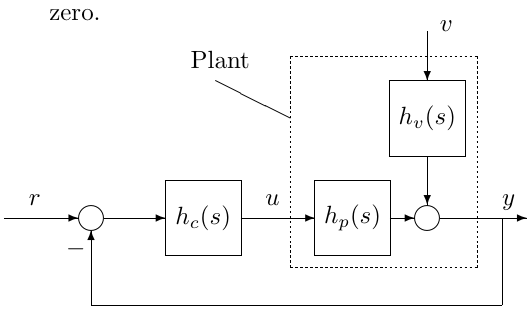
Figure 1: Control feedback system. Plant